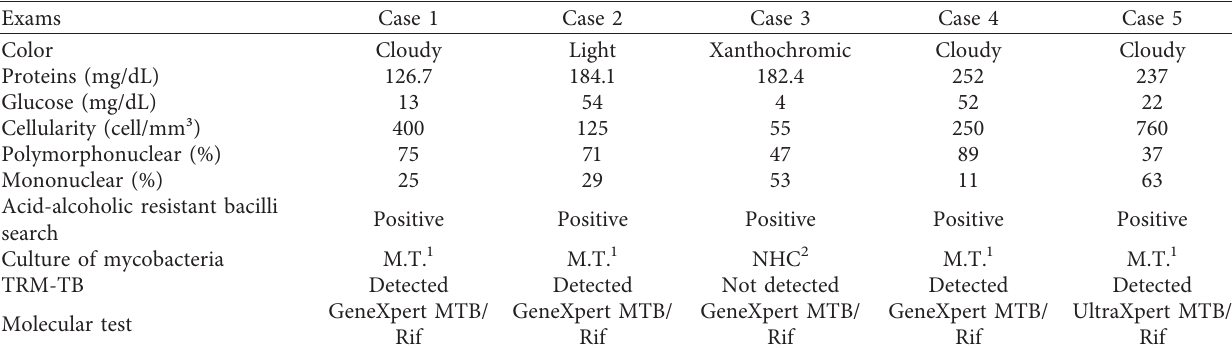
Table 2: CSF analysis of tuberculous meningitis cases in people with HIV/AIDS with positive AFB and/or detectable TRM-TB.